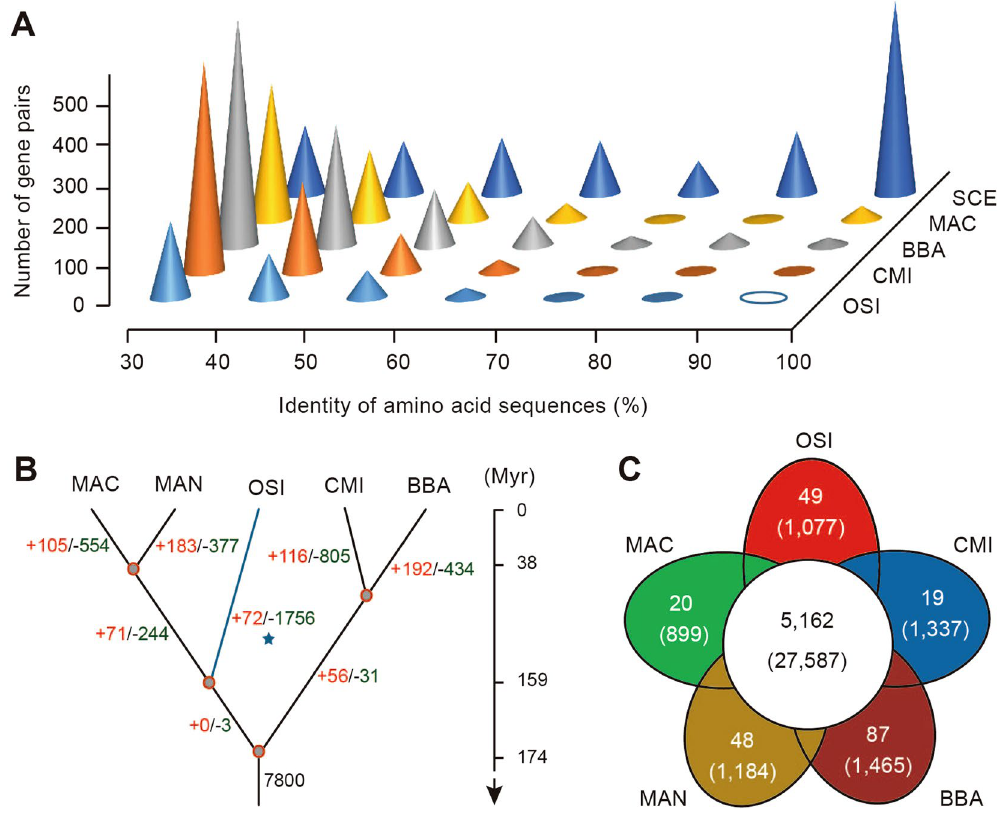
Figure 2. Gene family evolution. ( A ) Characterization of the paralogous genes among five entomopathogenic fungi. Abbreviations: OSI, O . sinensis ; MAN, M . anisopliae ; MAC, M . acridum ; CMI, C . militaris ; BBA, B . bassiana; SCE, S. cerevisiae . The x-axis shows the amino acid identity for each paralogous pair, while z-axis indicates the total number of paralogous genes within identity groups. Paralogous gene pairs are detected based on all- vs -all comparisons within the same species using Blastall program (version 2.2.26). ( B ) Gene expansion and contraction in the O . sinensis genome. The numbers of gene families showing expansion (red) or contraction (green) for each lineage after speciation are indicated on each branch of the phylogenetic tree with the position of O . sinensis highlighted (blue asterisk). ( C ) Venn diagram depicting unique and shared gene families among the five fungal genomes. Actual gene numbers are indicated